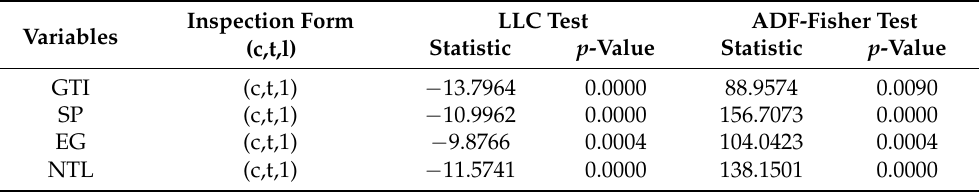
Table 1. Panel stationarity test of variables.